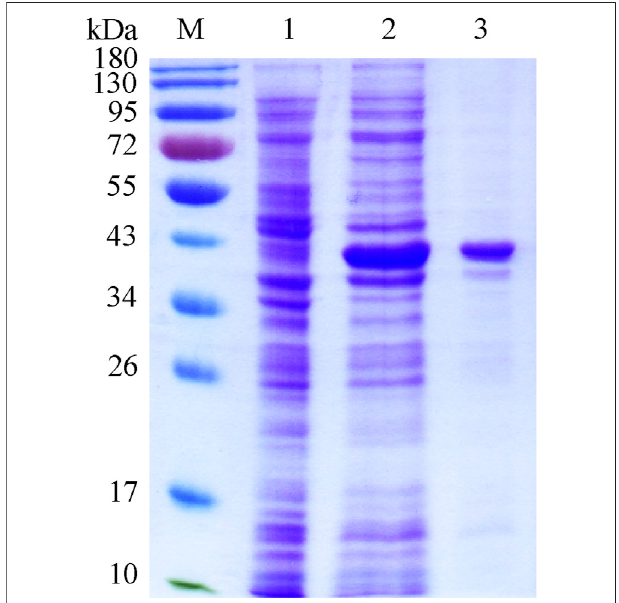
FIGURE 2 | SDS-PAGE of recombinant WciN. Lane M , protein molecular weight standards; lane 1 , whole E. coli BL21(DE3) cells with empty plasmid pET-28b; lane 2 , crude extract of expression strain of WciN; lane 3 , puri fi ed fusion protein His 6 -WciN-His 6